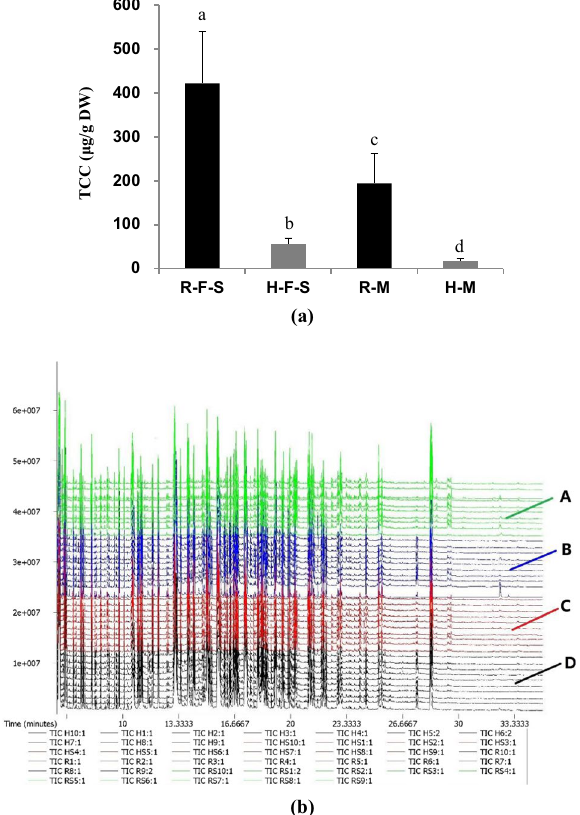
Figure 1. ( a ) The total carotenoid content (TCC) in different muscle tissues of orange and common abalones ( μ g/g DW), where orange-foot muscle (R-F-S), orange-adductor muscle (R-M), common-foot muscle (H-F-S), and common-adductor muscle (H-M) represents. ( b ) GC-TOF-MS total ion chromatograms (TICs) of different muscle parts of orange and common abalone extracts: (A) R-F-S, (B) R-M, (C) H-F-S, (D)